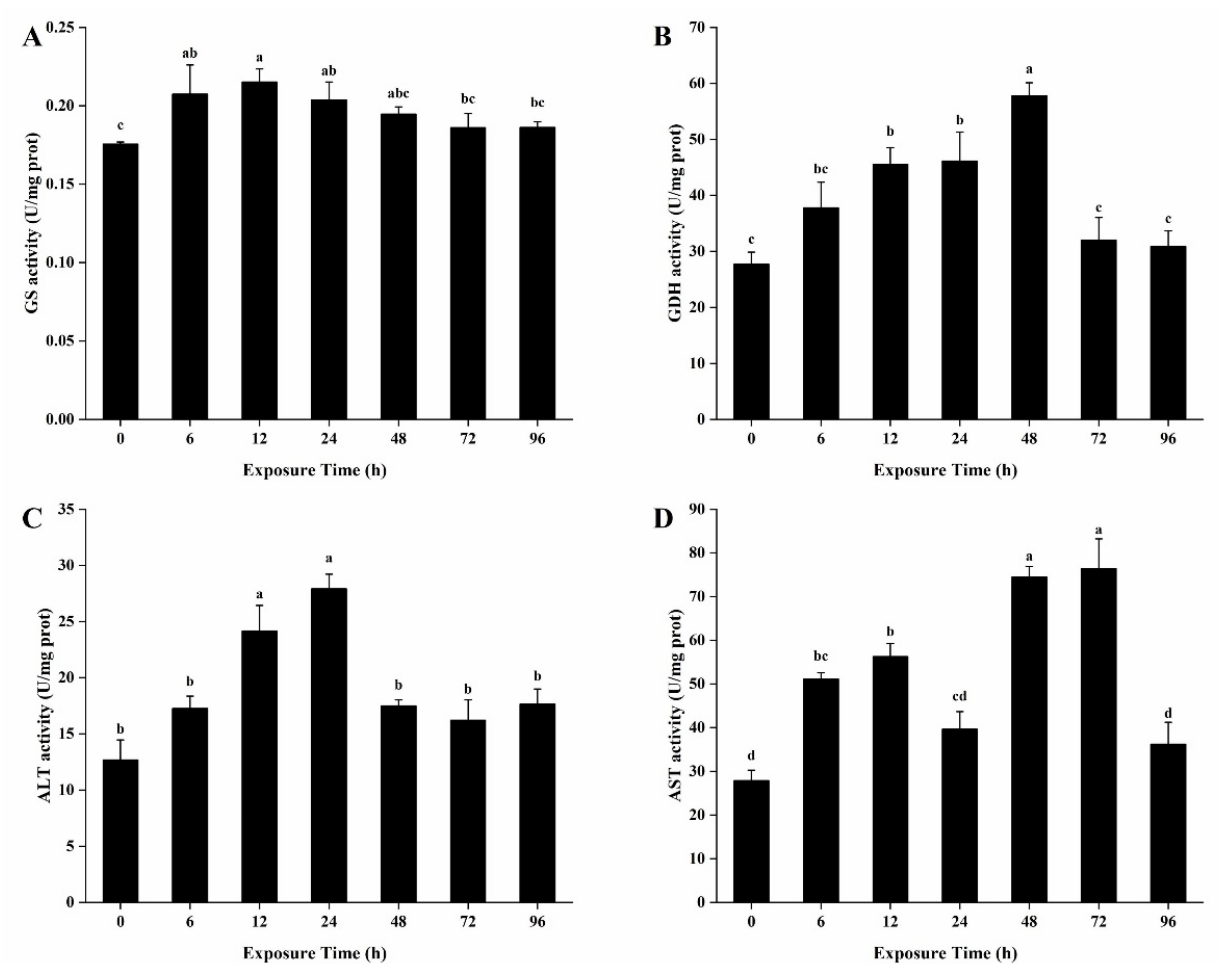
Figure 6. The activities of GS ( A ), GDH ( B ), ALT ( C ), and AST ( D ) in the hepatopancreas of H. cumingii exposed to 6.43 mg L − 1 unionized ammonium for 0 (control), 6, 12, 24, 48, 72, and 96 h. Values are presented as the mean ± SE ( n = 6). Superscripted lowercase letters indicate a significant effect of exposure time ( p < 0.05).